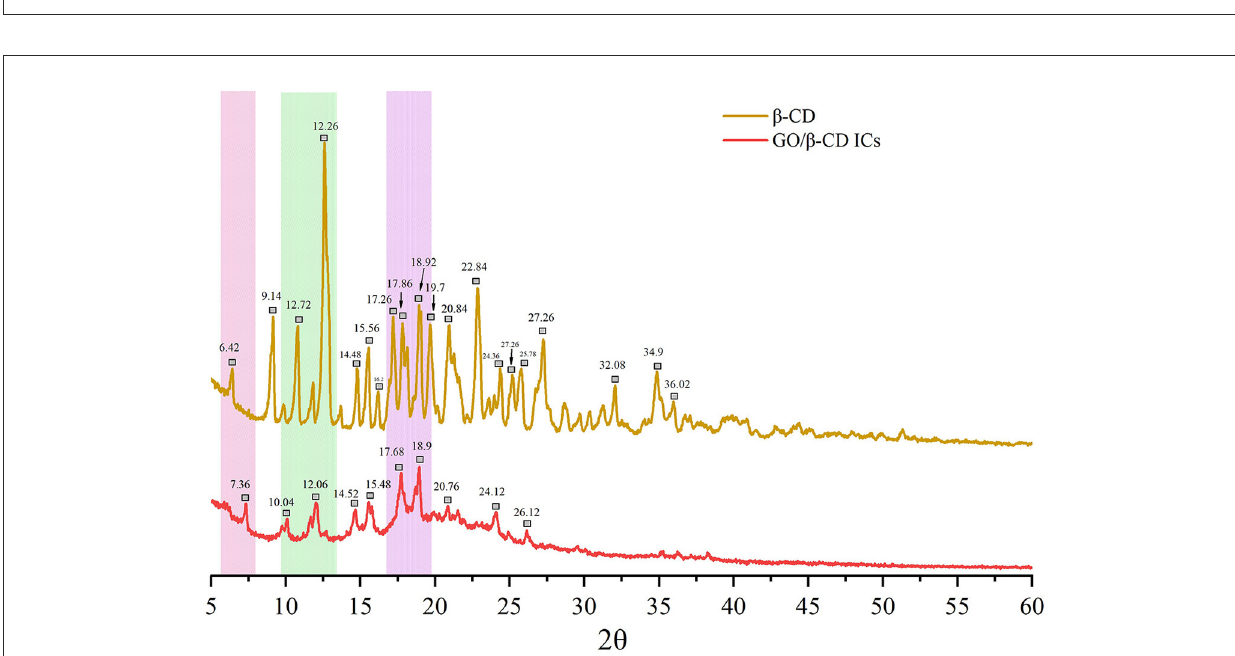
FIGURE10 XRD patterns of GO/ β -CD ICs and β -CD